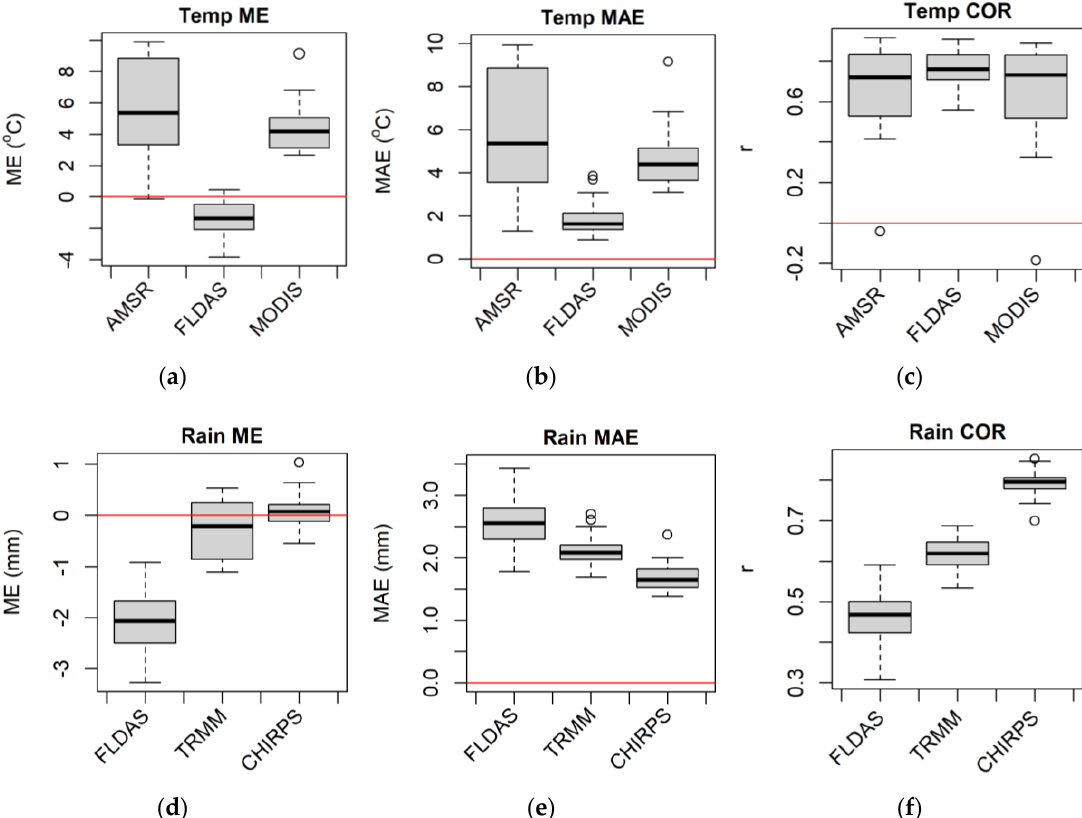
Figure 9. Pixel-level satellite/interpolated temperature ( a – c ) and rainfall ( d – f ) daily data accuracy statistics box plots over 22 meteorological stations distributed in Amhara Region, Ethiopia for 2003–2016.